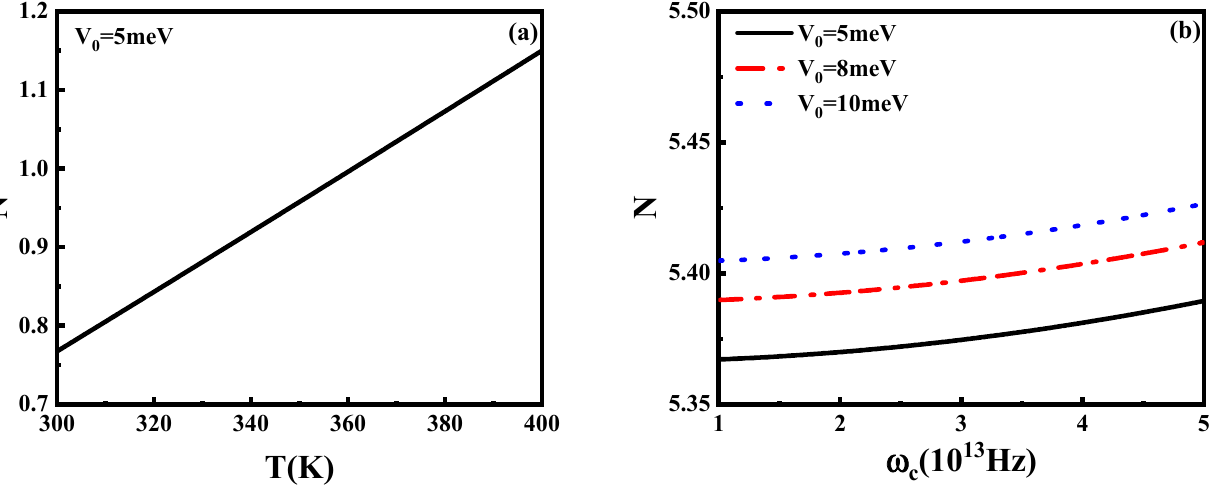
Figure 12. LO-phonon mean number N versus ( a ) temperature T and ( b ) magnetic field’s cyclotron frequency ω c .